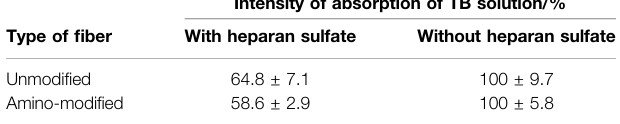
TABLE 1 | Absorption of TB solution after contact with unmodi fi ed fi bers without and with HS as well as amino-modi fi ed fi bers without and with HS. Intensity of absorption of TB solution/% Type of fi ber With heparan sulfate Without heparan sulfate